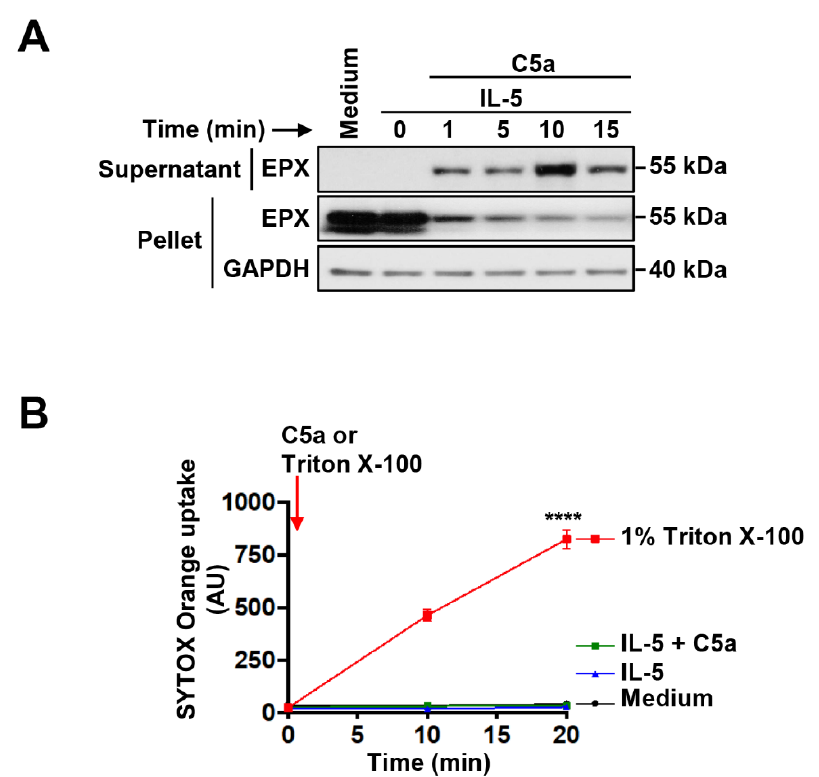
Figure 2. Time-dependent EPX release by viable human eosinophils. Human eosinophils were primed with IL-5 and subsequently stimulated with C5a for the indicated times. ( A ) The presence of EPX in the cell pellet and the supernatant fraction was detected by immunoblotting with monoclonal mouse anti-EPX antibody. GAPDH protein levels were analyzed as loading controls. A representative immunoblot of two independent experiments is shown. ( B ) Viability assay. Activated human eosinophils exhibited no SYTOX Orange uptake, indicating intact plasma membrane during the entire period of the experiment. **** p <